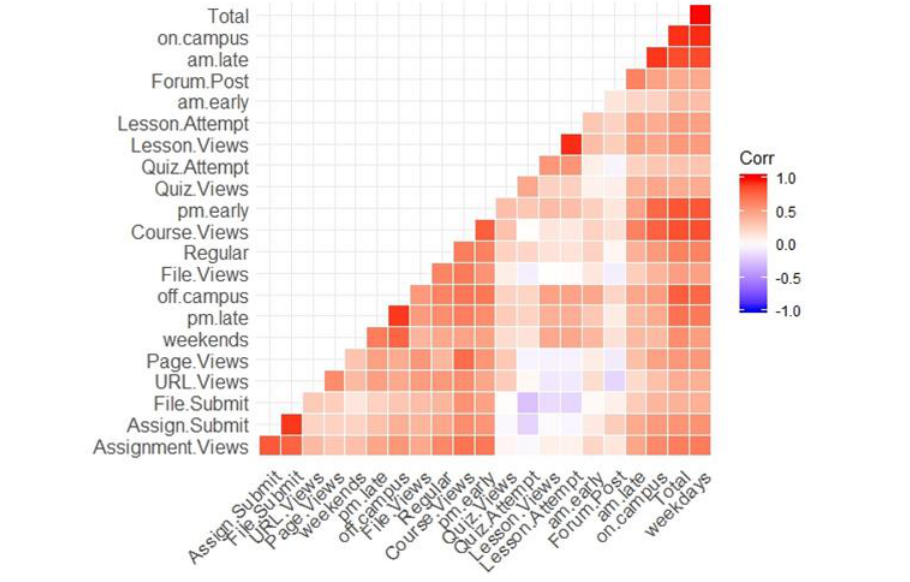
Figure 3: Correlation matrix of Predictor